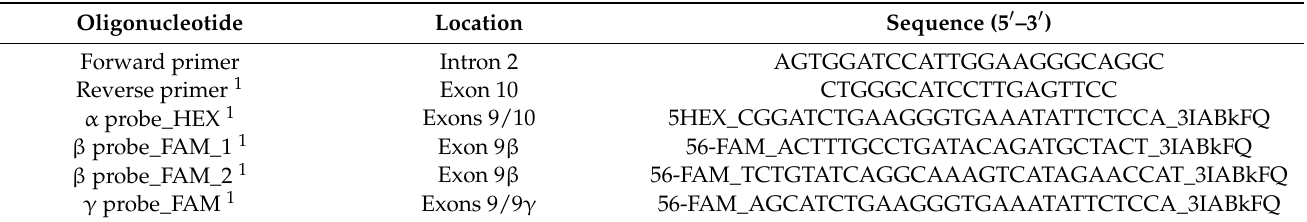
Table 6. Description of primers and probes for TP53 t8 , t8 β and t8 γ long amplicon ddPCR assay. Oligonucleotide